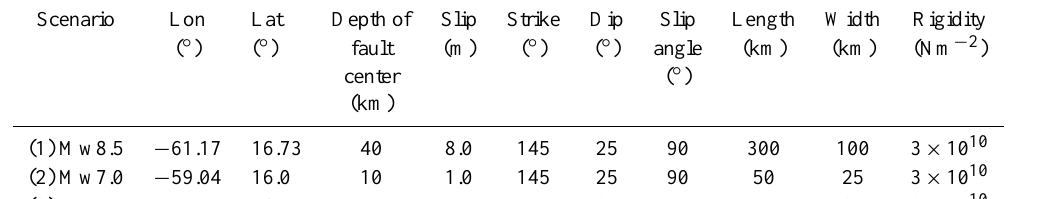
Table 1. Rupture parameters of a 1843-like M w =8.5 scenario, M 0 =6.92 × 10 21 Nm − 2 and for two M w =7.0 scenarios varying the strike angle.